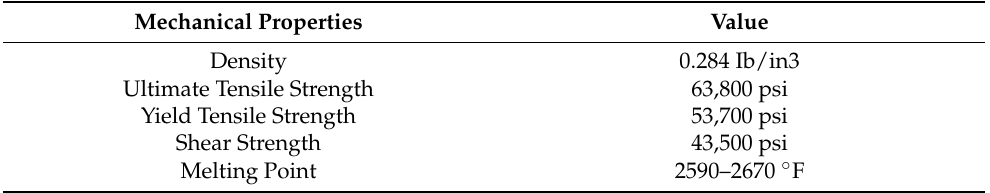
Table 1. Properties of the A108 steel used in the